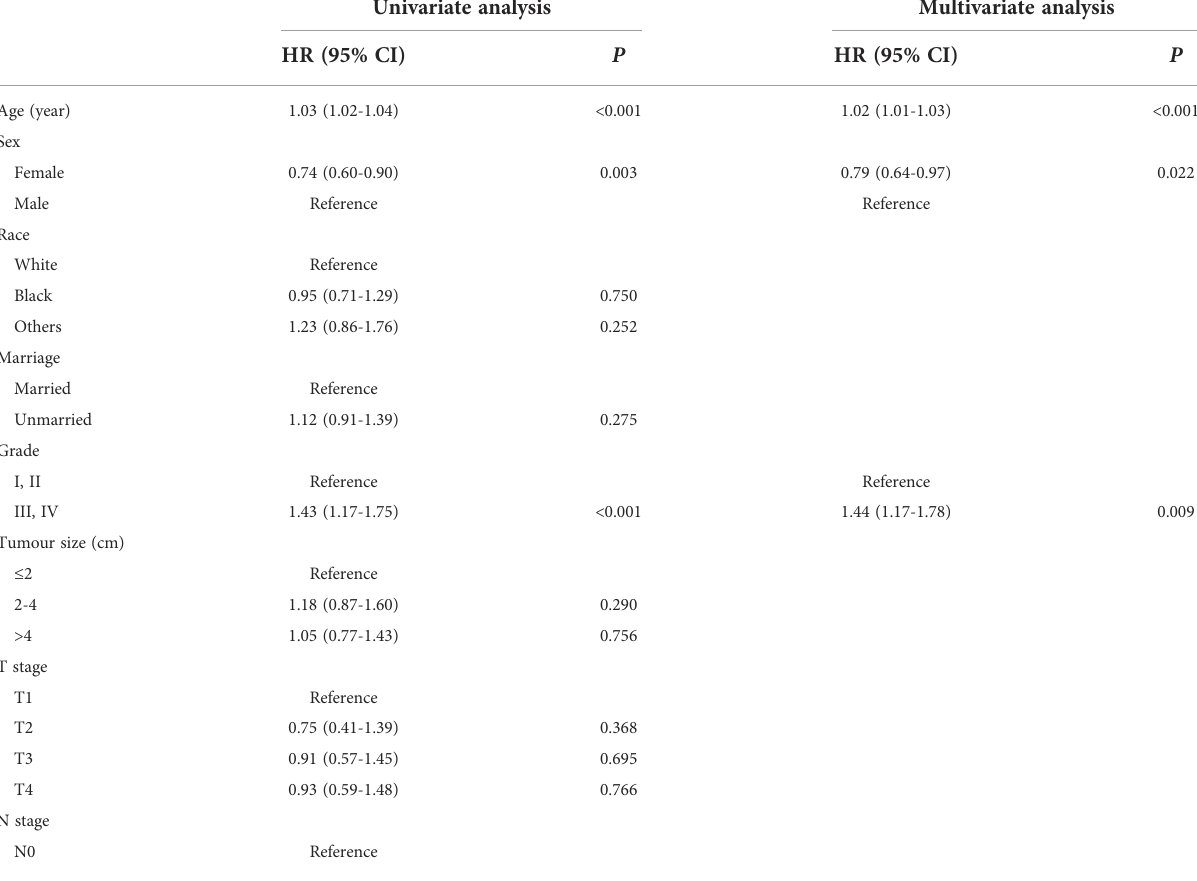
TABLE 2 Univariate and multivariate analysis of overall survival (OS) in the training set. Univariate analysis Multivariate